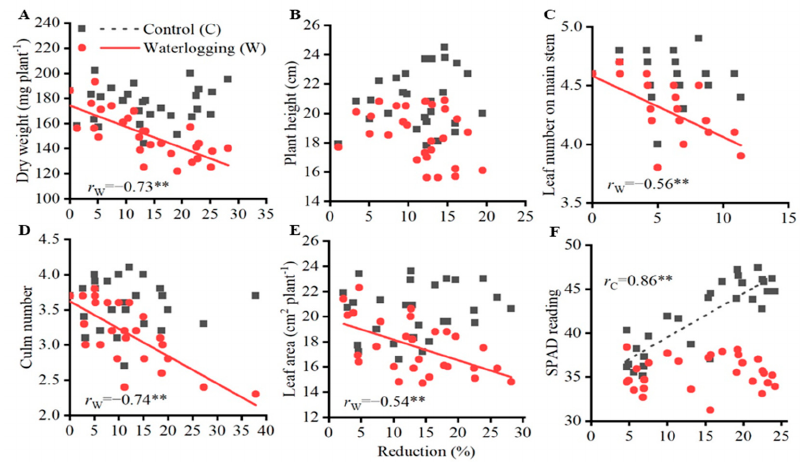
Figure 2. Relationships of dry weight ( A ), plant height ( B ), leaf number on main stem ( C ), culm number ( D ), leaf area ( E ), and SPAD reading ( F ) of different cultivars under the control condition and waterlogging treatment with their percentage reduction caused by waterlogging treatment. ** indicates significance at the 0.01 probability level. Table 4. Correlation coefficients between percentage reductions in different agronomic traits.